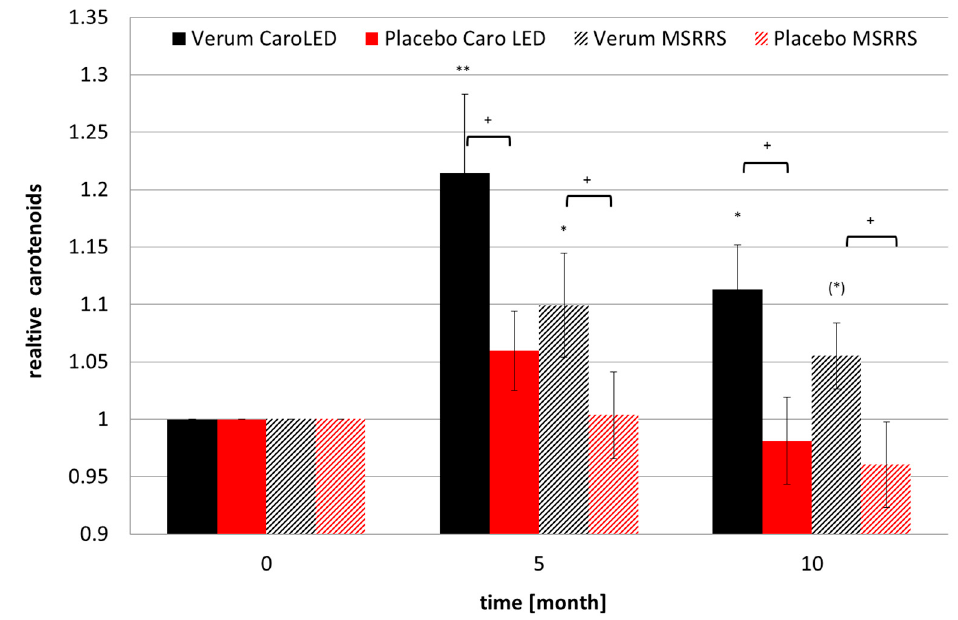
Figure 1. Carotenoid values relative to the initial values measured by two different carotenoid sensors obtained in the palm (mean ± SEM). + p < 0.05 between placebo and verum; ( * ) p < 0.1, * p < 0.05, ** p < 0.01 to initial value. N = 15 for placebo and N = 14 for verum.